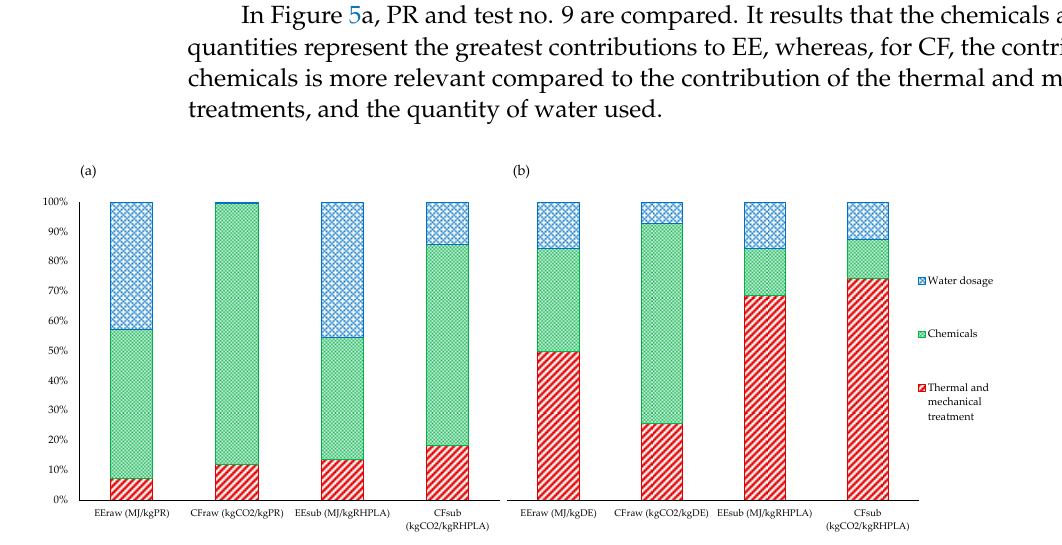
Figure 5. Bar chart results of the embodied energy (EE) and carbon footprint (CF) for the raw process (raw) and the new proposed process (sub), showing the relative contribution of the single procedure steps (water dosage, chemical reagents, thermal and mechanical treatment). ( a ) Represents the case of test no. 9 in process 1 (devoted to P recovery), while ( b ) represents process 2 (devoted to silica recovery).